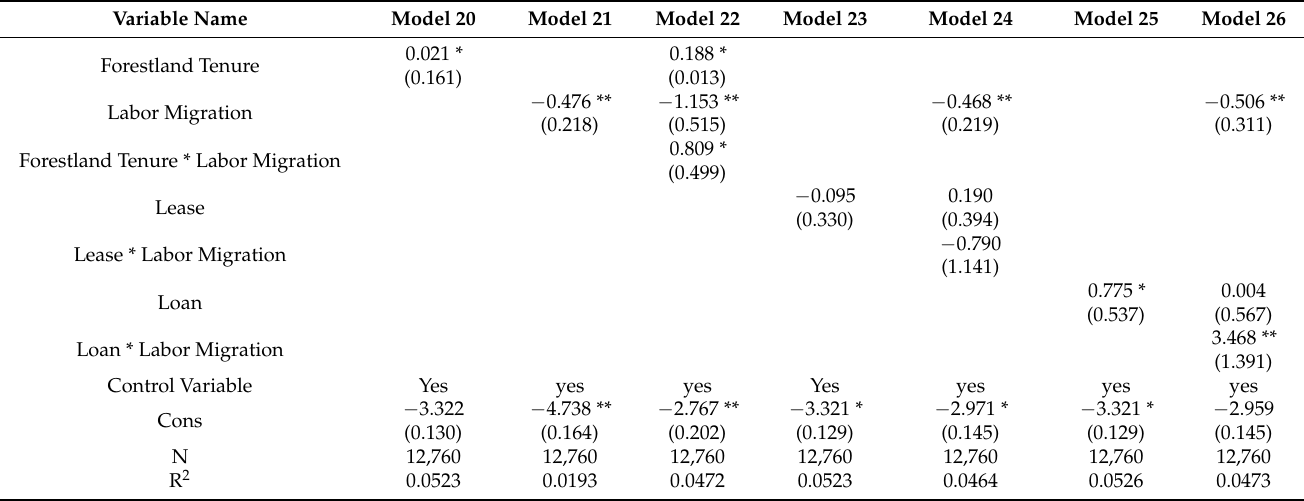
Table 5. Estimated results of the moderating role of labor migration on labor